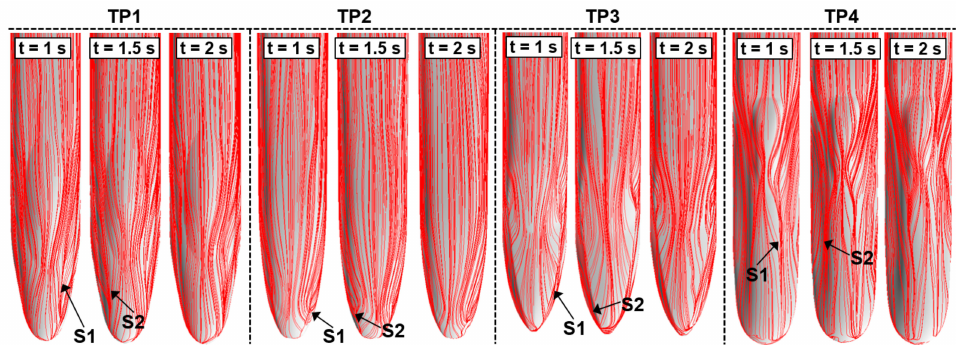
Figure 18. Streamlines on the tail surface at different timesteps.